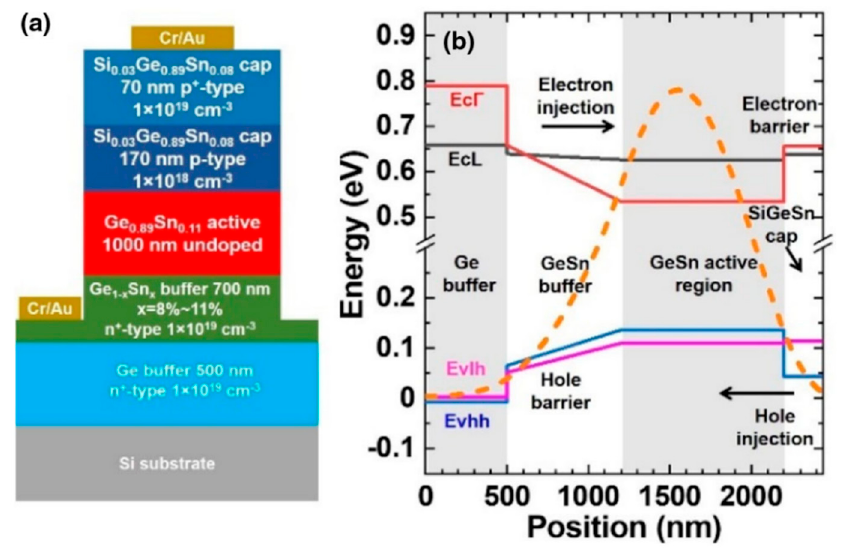
Figure 36. ( a ) Cross-sectional device structure for the first electrically injected FP cavity GeSn/SiGeSn laser; ( b ) calculated band structure and fundamental TE mode profile. Reproduced from [89], OSA Publishing, open access,